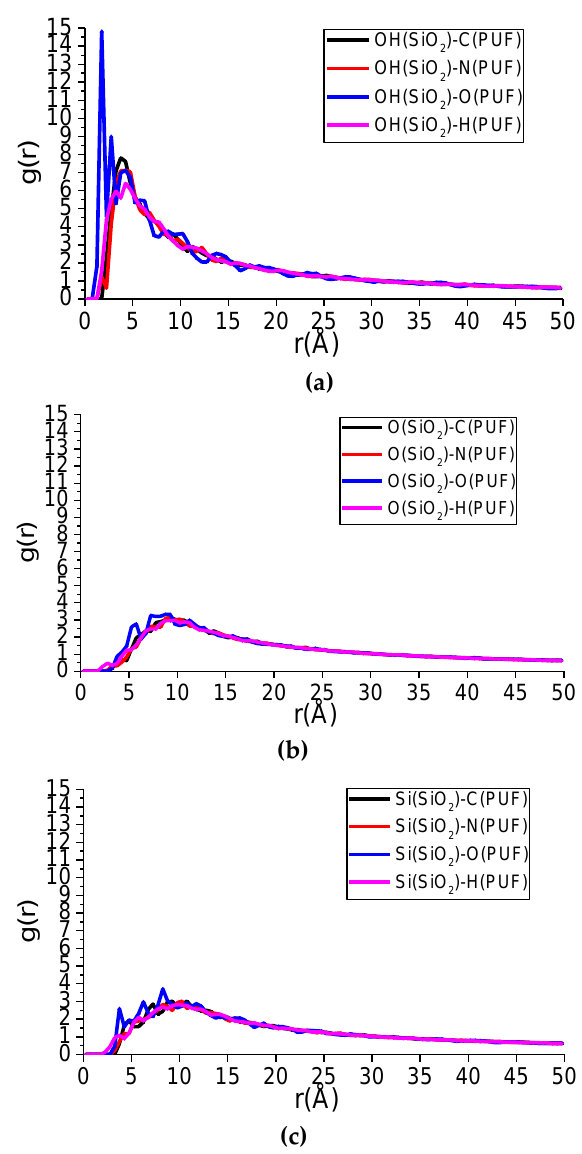
Figure 12. Pair correlation function (PCF) of the PUF–SiO 2 interface interaction. ( a ) PCFs of OH(SiO 2 )-PUF; ( b ) PCFs of O(SiO 2 )-PUF; ( c ) PCFs of Si(SiO 2 )-PUF.